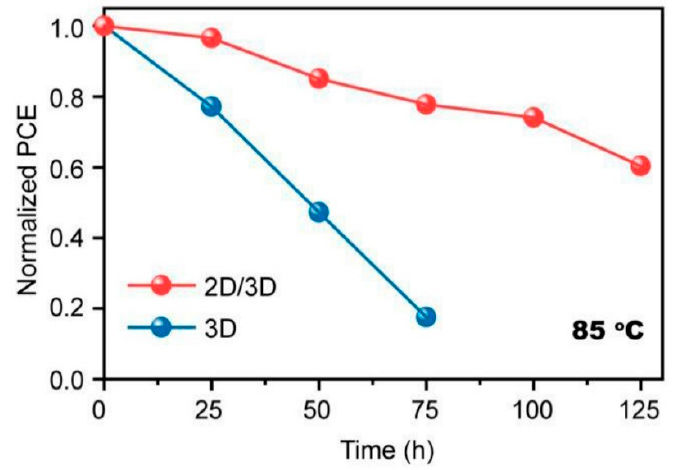
Figure 10. Thermal stability of devices based on 3D and 3D / 2D bilayered perovskite films. Reprinted with permission from Ref. [45] Copyright 2020 American Chemical Society.